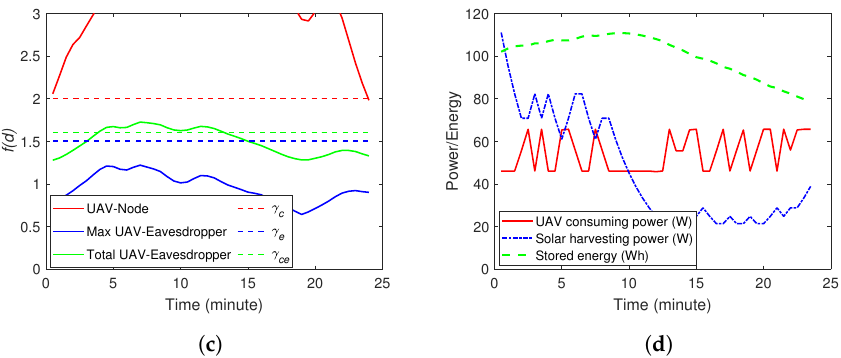
Figure 3. Simulation results in Environment 1 by the benchmark method. ( a ) The UAV movement on x-y plane. A video is available: https://youtu.be/kGFlpWV-SkQ. ( b ) The UAV altitude. ( c ) The communication and eavesdropping performance. ( d ) Energy consumption and solar energy harvesting.